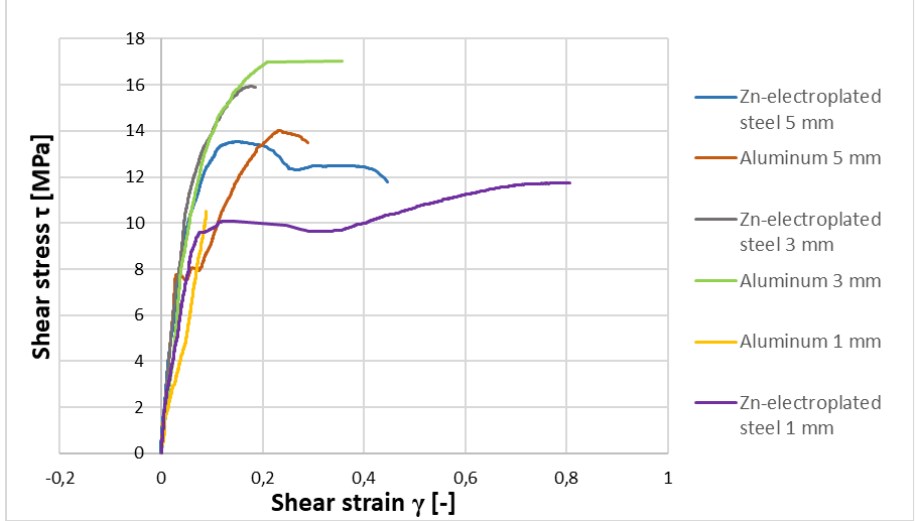
Fig. 6 Stress-strain relationship for reference set of specimens.